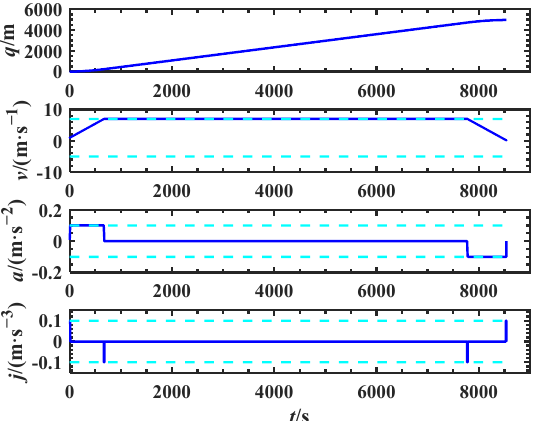
Figure 14. Planned profiles for position, velocity, acceleration, and jerk.